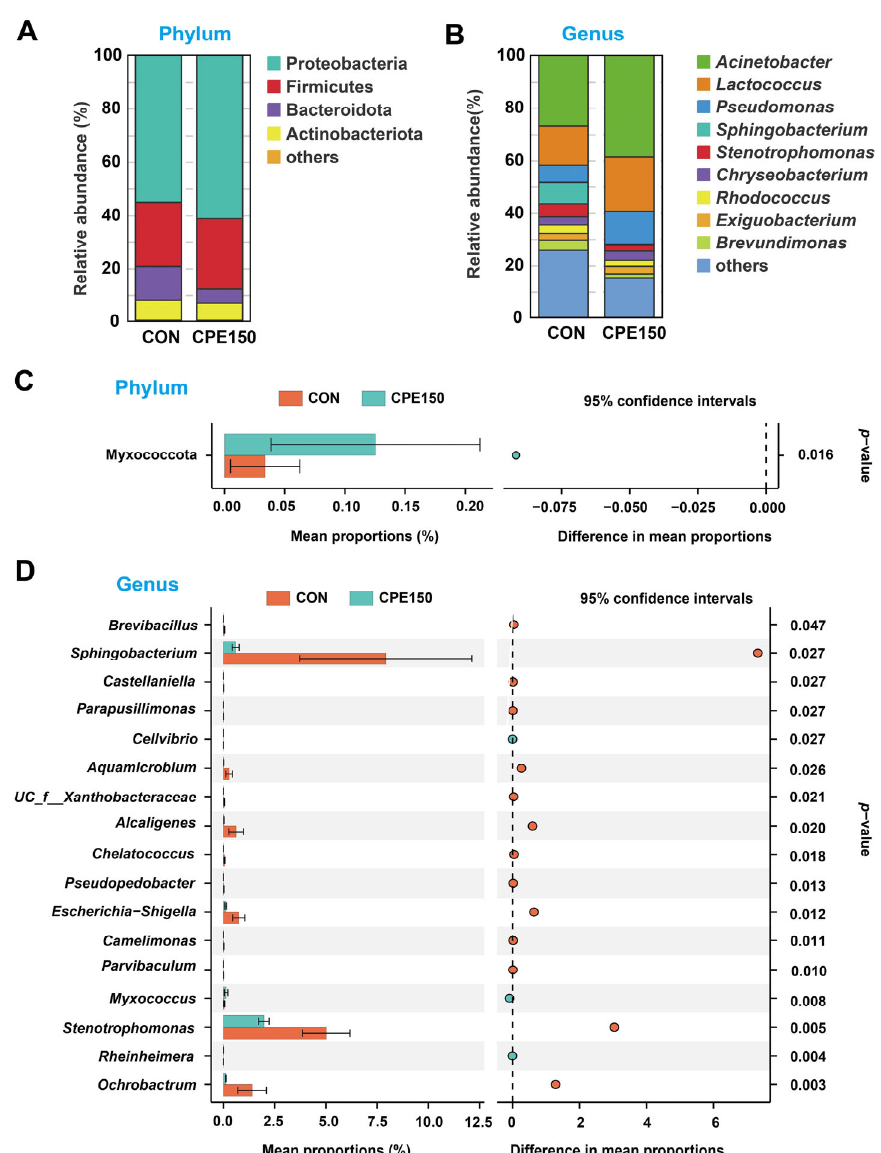
Figure 2. Comparison of the bacterial composition between the milk of cows fed the control diet (CON), and supplementary citrus peel extracts at 150 g/d (CPE150). Composition of milk bacteria at the phylum level ( A ) and genus level ( B ); Differential bacterial taxa at the phylum level ( C ) and genus level ( D ). A Wilcoxon rank-sum test was used to test differences in taxa abundance between two treatments ( n = 8 per